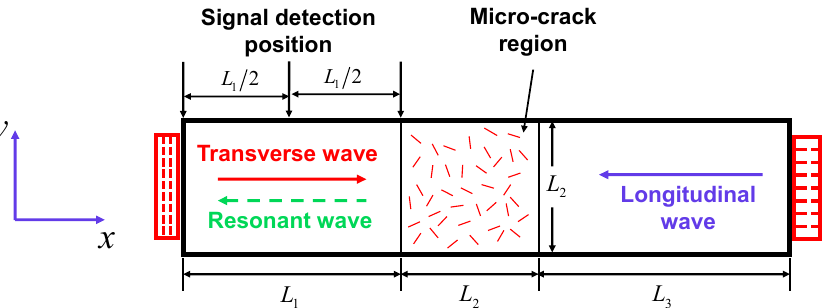
Figure 1. Schematic of two-way collinear mixing in an elastic solid with randomly distributed mi- cro-cracks.